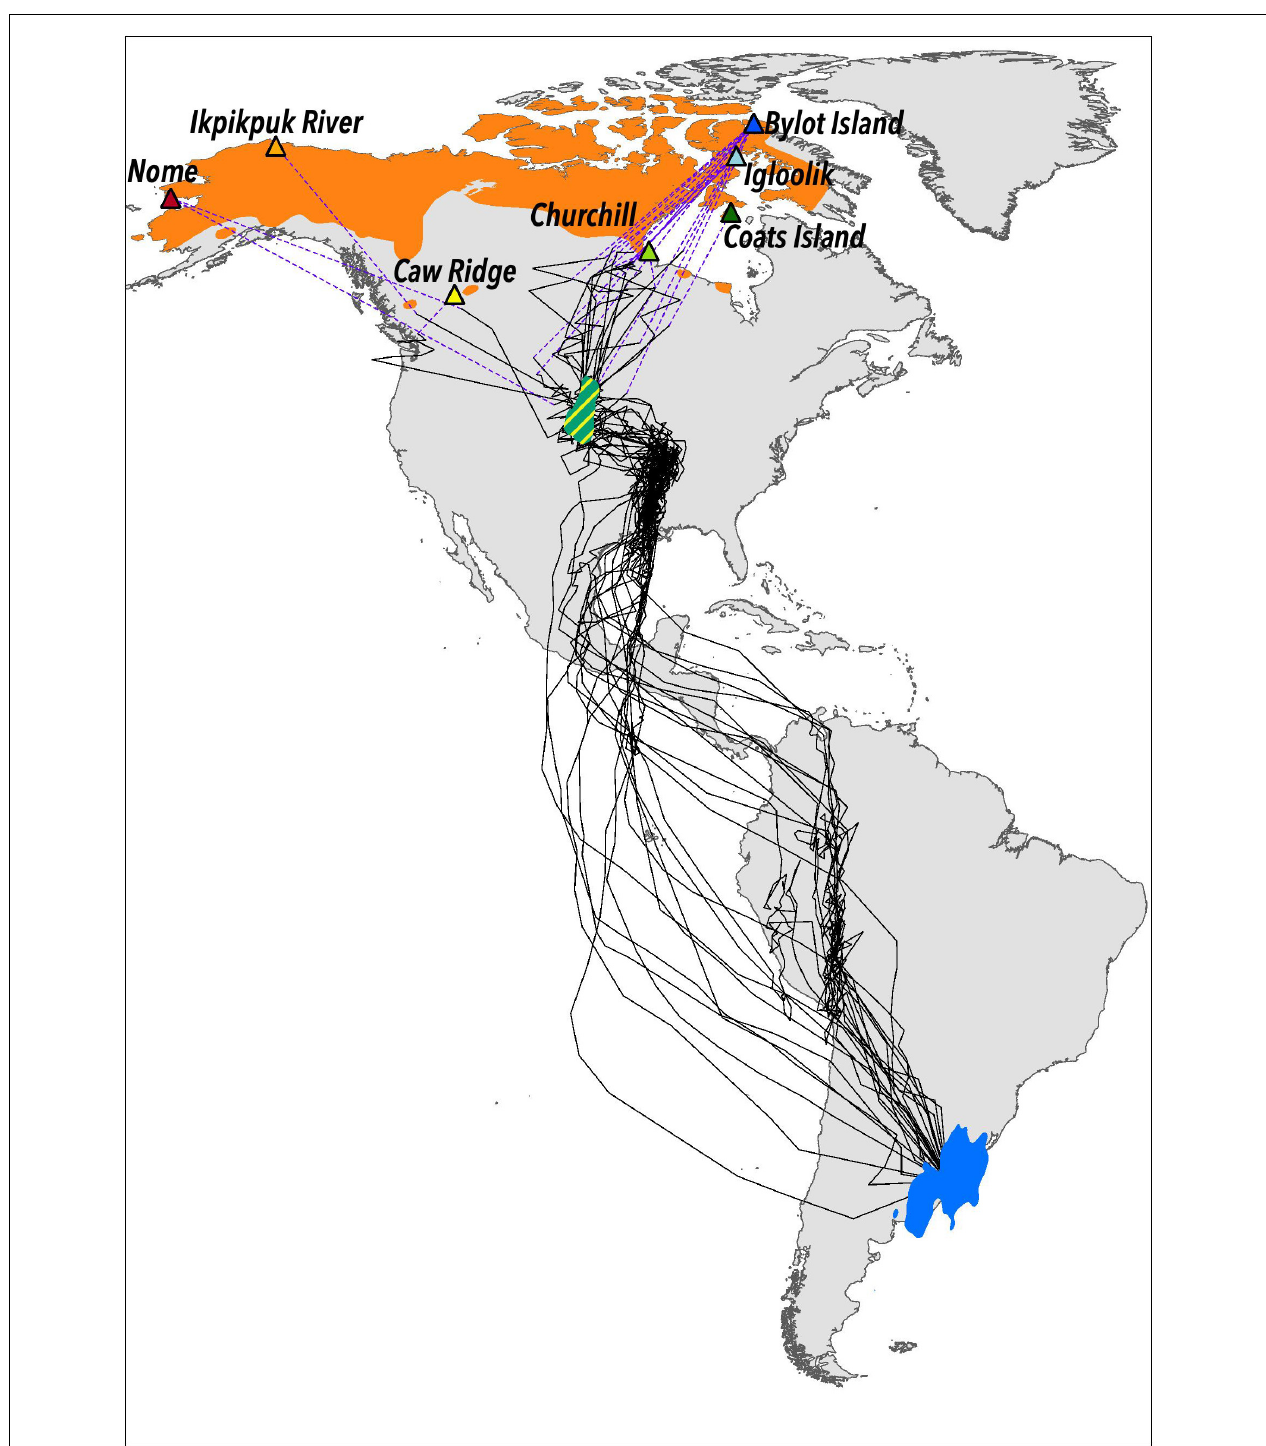
FIGURE 1 | American Golden-Plover ( Pluvialis dominica ) breeding range (orange; based on Johnson et al., 2020a), non-breeding (wintering) area (blue polygon) and last shared spring stopover area (green polygon with yellow stripes) located in Nearctic temperate grasslands of the Midwestern United States (mostly South Dakota, Nebraska, and Kansas). Wintering and shared stopover areas were defined with Kernel density estimation (75%) based on locations of individuals marked with light-level geolocators ( n = 23; black lines illustrate individual tracks). Purple dashed lines represent straight lines between last location obtained for an individual and its breeding location. Birds were captured and marked at study areas (triangles) distributed across the breeding range.